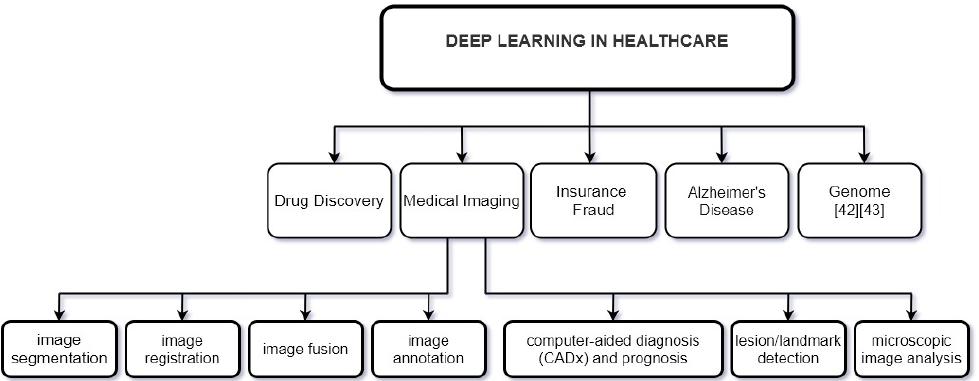
Figure 2. Deep learning in